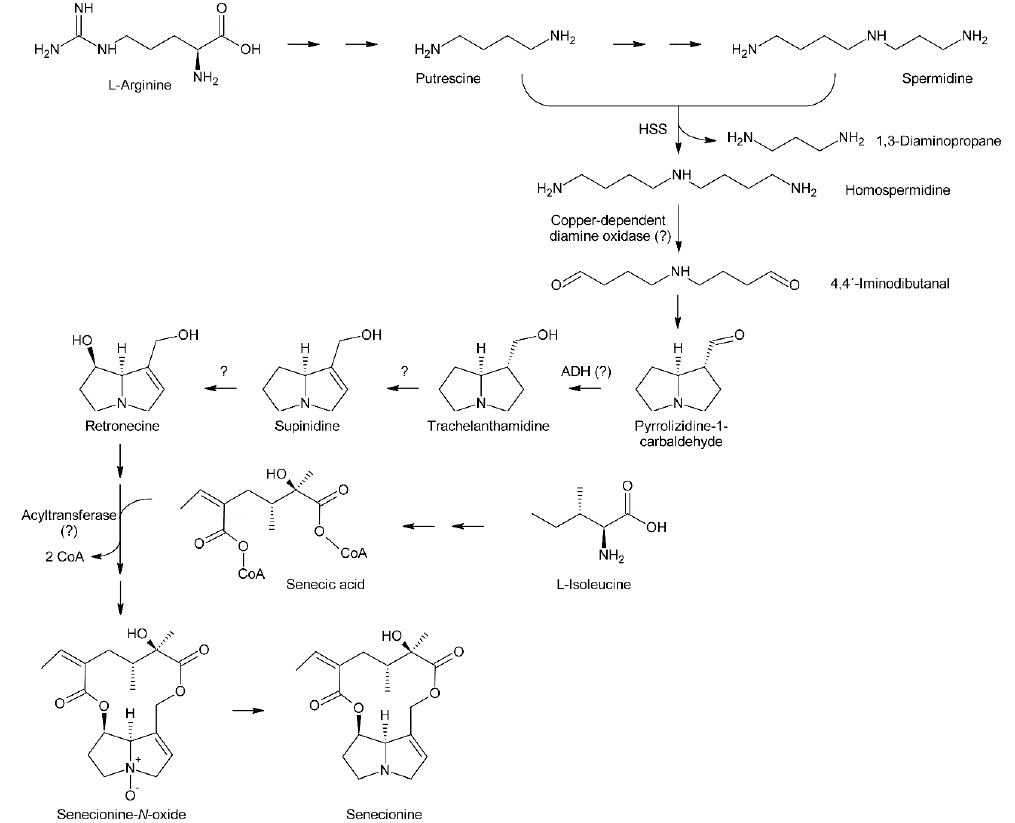
Figure 6. Biosynthesis of PAs. The polyamines putrescine and spermidine are derived from the basic amino acid arginine. Subsequently, homospermidine synthase (HSS) exchanges the 1,3-diamonopropane residue of spermidine by putrescine, which releases 1,3-diaminopropane and forms symmetric homospermidine. Oxidation of homospermidine, likely by copper-dependent diamine oxidases, to 4,4´-iminodibutanal initiates cyclization to pyrrolizidine-1-carbaldehyde, which is reduced, likely by an alcohol dehydrogenase, to 1-hydroxymethylpyrrolizidine. Desaturation and hydroxylation by unknown enzymes form retronecine, which is acylated with an activated necic acid, for instance with senecyl-CoA 2 as in the example shown above. Acylation might be catalyzed by an acyltransferase of the BAHD family. PA N -oxides, which are believed to be the primary products of PA biosynthesis, may be reduced to the free tertiary